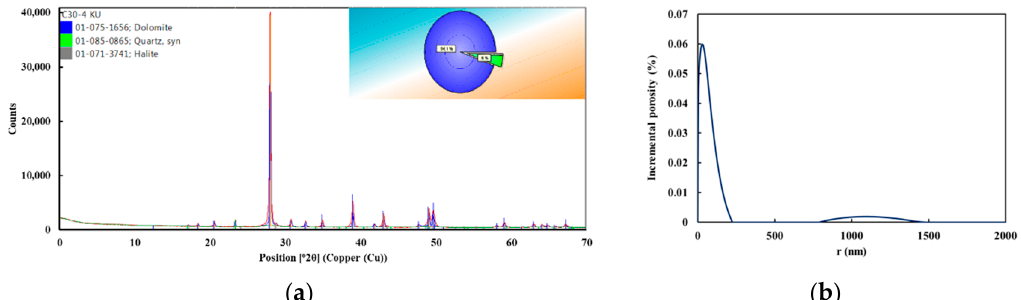
Figure 1. ( a ) X-ray powder diffraction (XRD) result of the sample and ( b ) pore size distribution of the core sample based on the nuclear magnetic resonance (NMR) result.